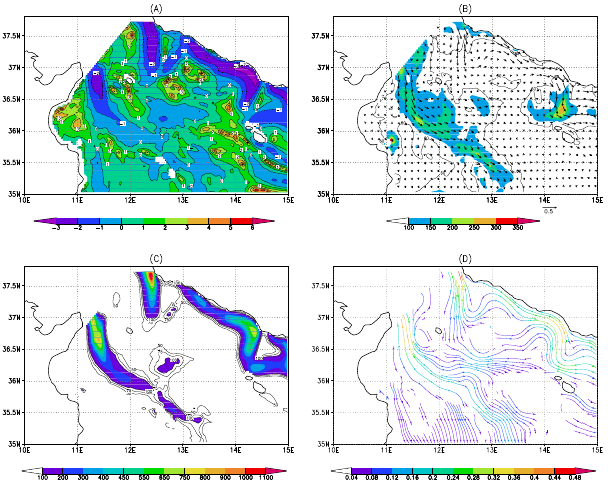
Fig. 9. December monthly map in the Sicily Channel sub-region for Φ (panel A ), mean flow [ms − 1 ] overlapped to EKE (panel B , [cm 2 s − 2 ]) and MKE (panel C , [cm 2 s − 2 ]) and streamlines of the mean flow ( D , [ms − 1 ]). Areas with MKE and EKE higher than 100cm 2 s − 2 are shaded.